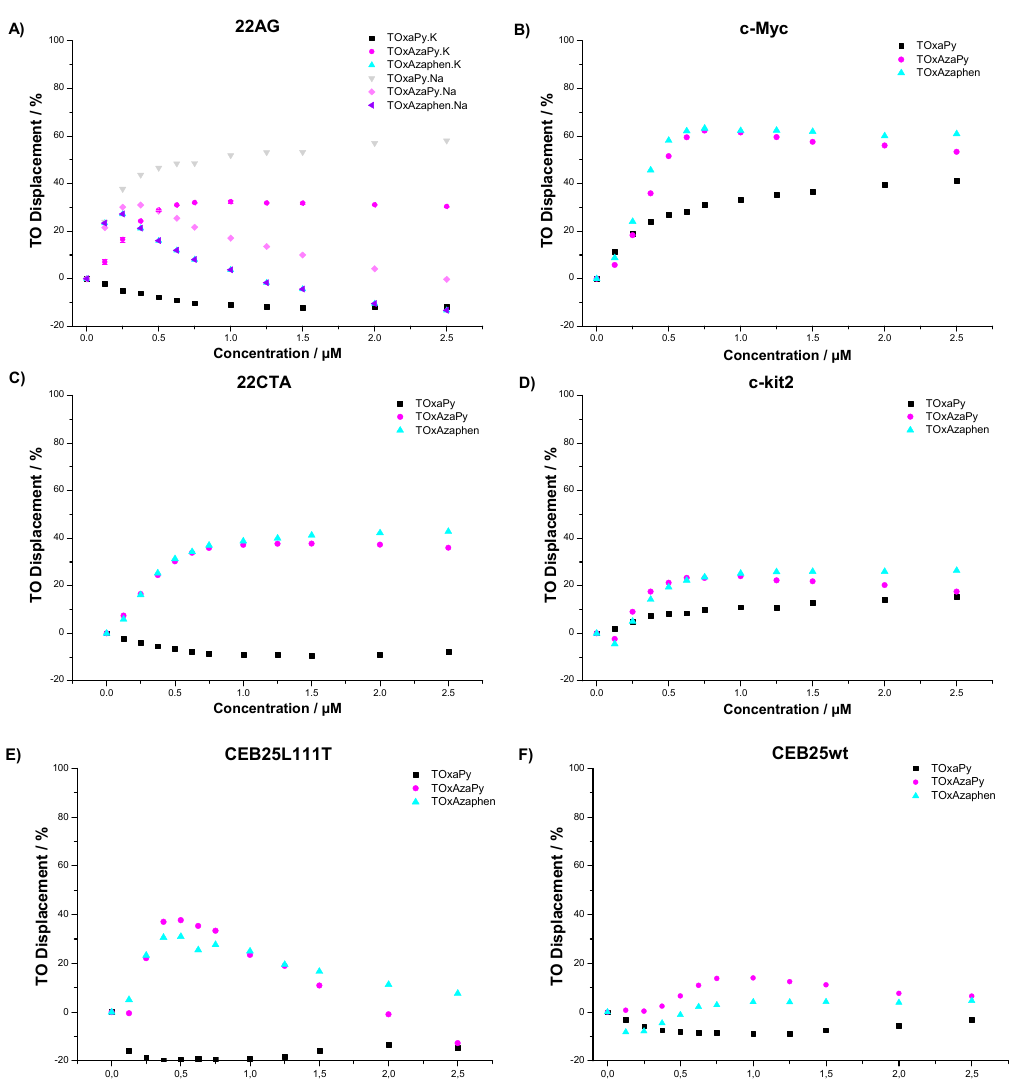
Figure 5. G4-FID plots of TOxAzaPy and TOxAzaPhen in the presence of: ( A ) 22AG.Na and 22AG.K; ( B ) c-Myc; ( C ) 22CTA; ( D ) c-kit2; ( E ) CEB25wt; and ( F ) CEB25L111T. TOxaPy is used as a reference compound.